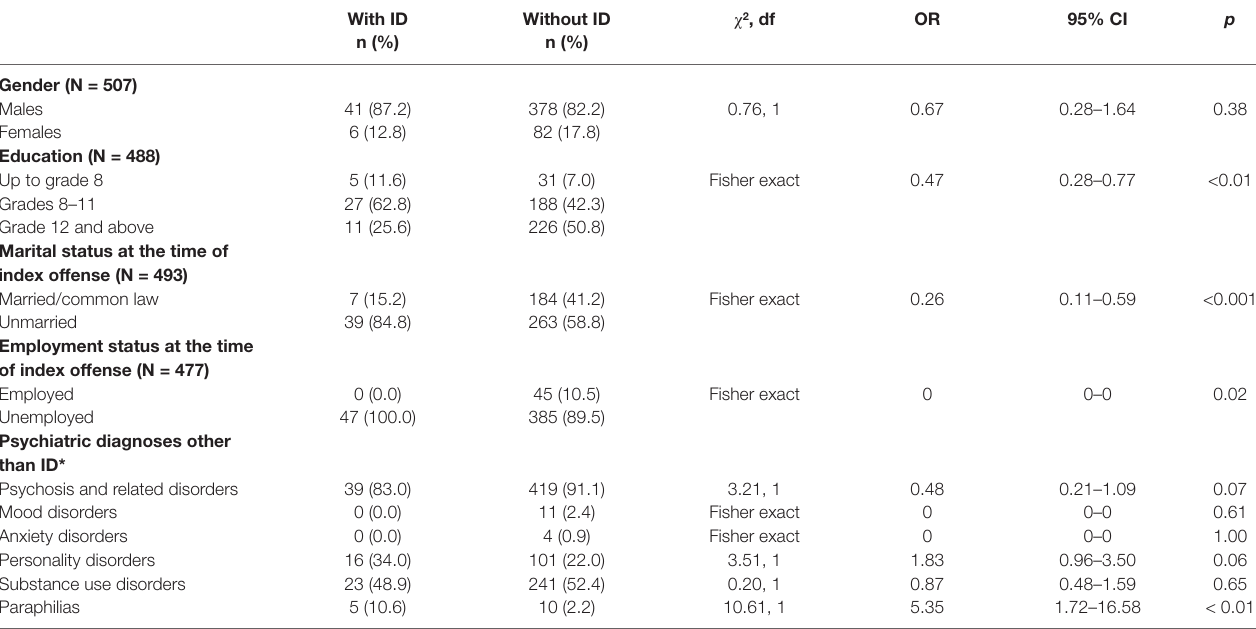
TABLE 2 | Sociodemographic and clinical characteristics of patients with and without an intellectual disability.